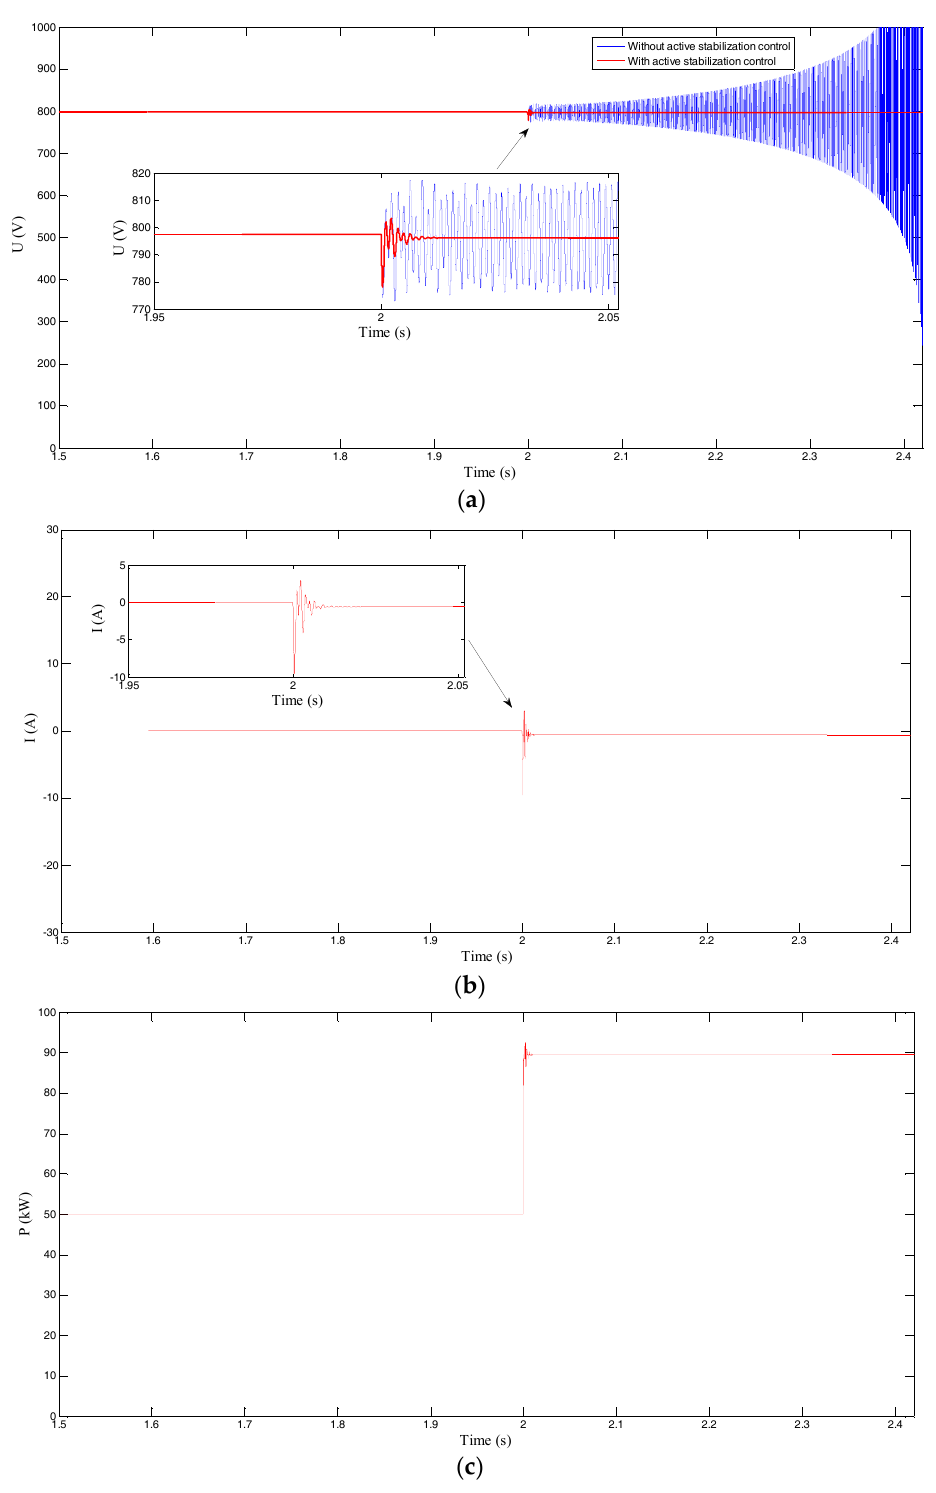
Figure 9. Simulation waveform by changing P s1 = 50 kW to P s1 = 90 kW at t = 2 s: ( a ) U s1 ; ( b ) i s1,active ; and ( c ) P s1 .